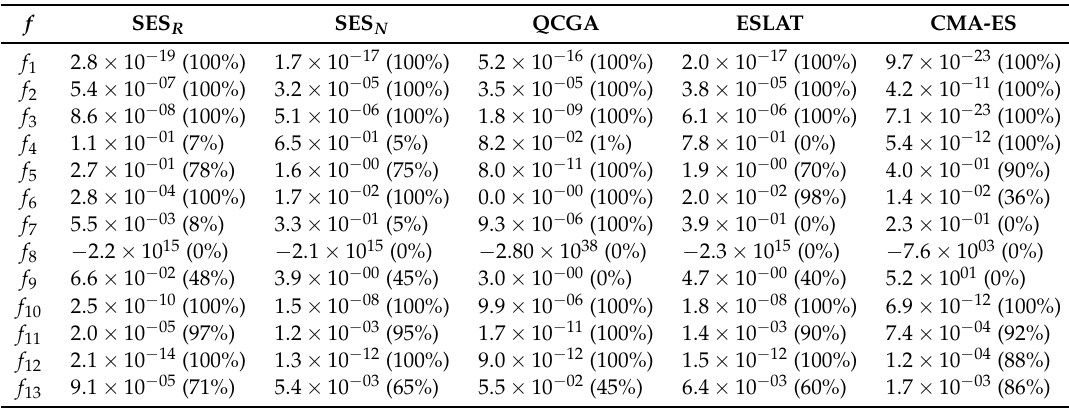
Table 4. Solutions qualities—average errors and success